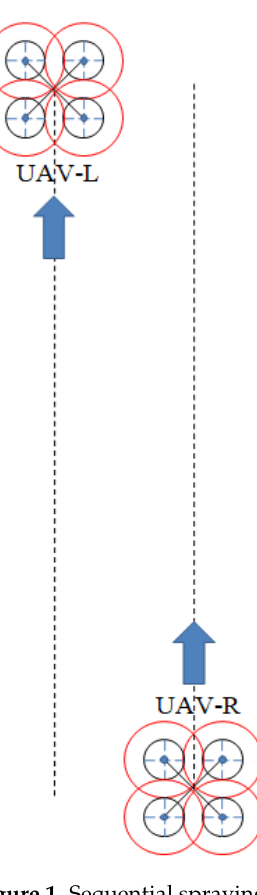
Figure 1. Sequential spraying.